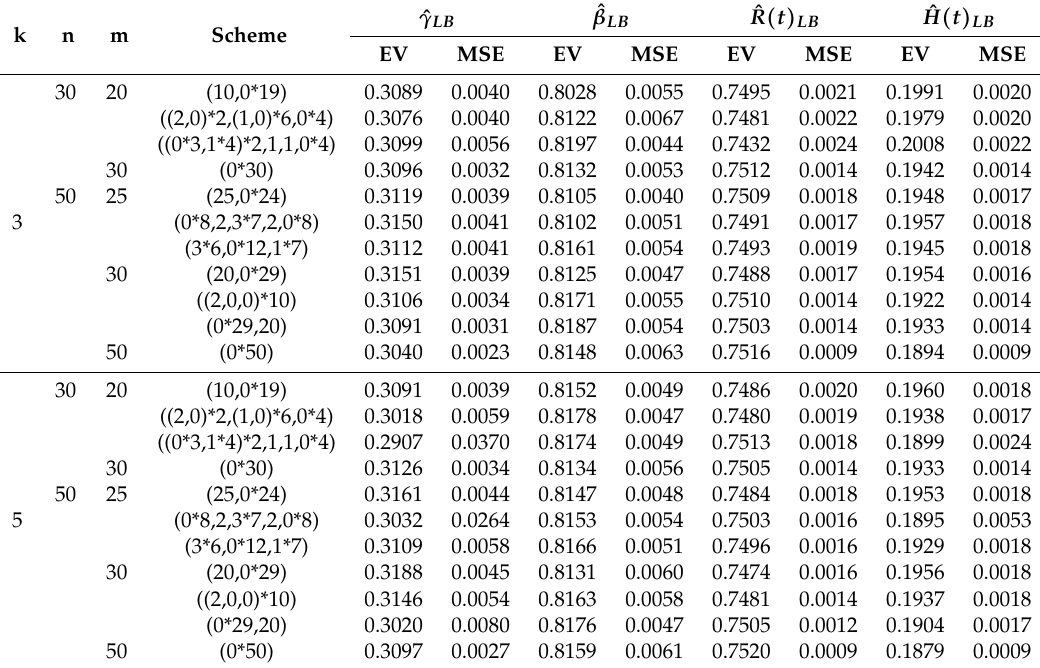
Table 4. Lindley approximation values and MSEs of parameters and reliability and hazard functions under SELF when γ = 0.3, β = 0.8, t = 1.5, a 1 = 1.08, b 1 = 3.6, a 2 = 16, b 2 = 20, R ( t ) = 0.7563, H ( t ) = 0.1786, N = 1000.